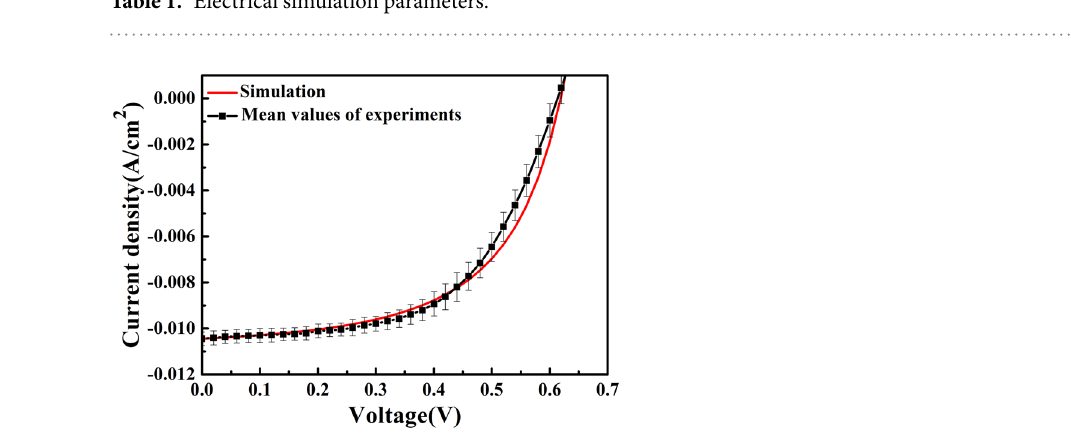
Figure 2. Experimental 28 and simulated results for current density versus voltage curves for a planar organic solar cell with a 200 nm thick active layer. Our model widely agrees with the experimental results.